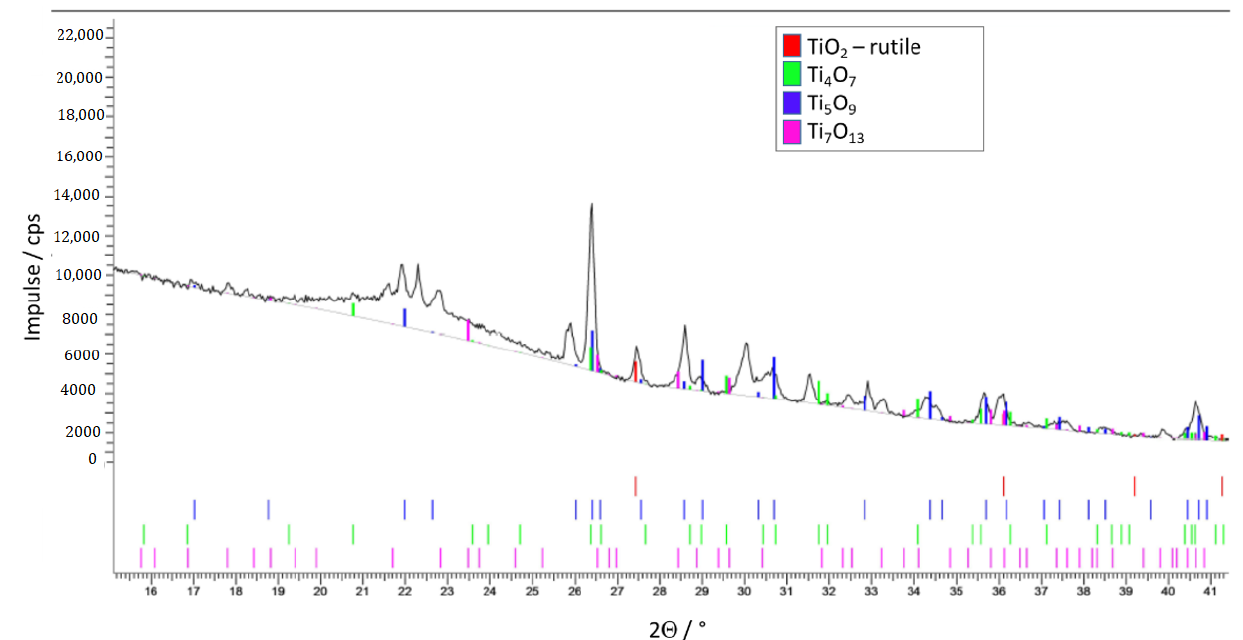
Figure 14. TiO x phases in the core of the test samples; measured at a cross ‐ section. Twinning is present at the more porous edges and near one crack (Figure 15a), but not in the inner region of the sample. Figure 15b shows a homogenous sample texture